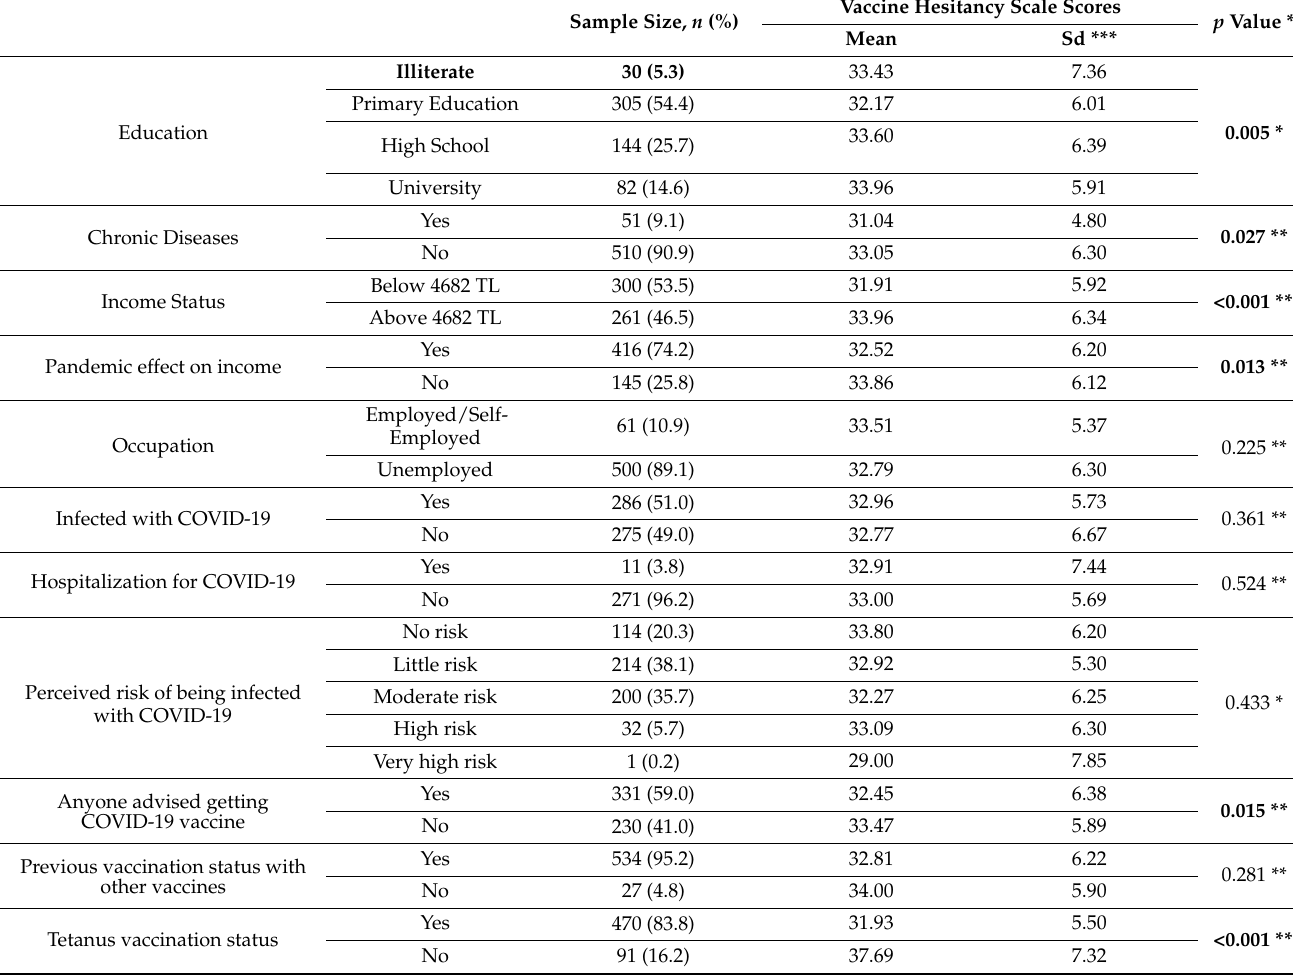
Table 1. Comparison of the sociodemographic characteristics of the participants according to the scores they received from the vaccine hesitancy